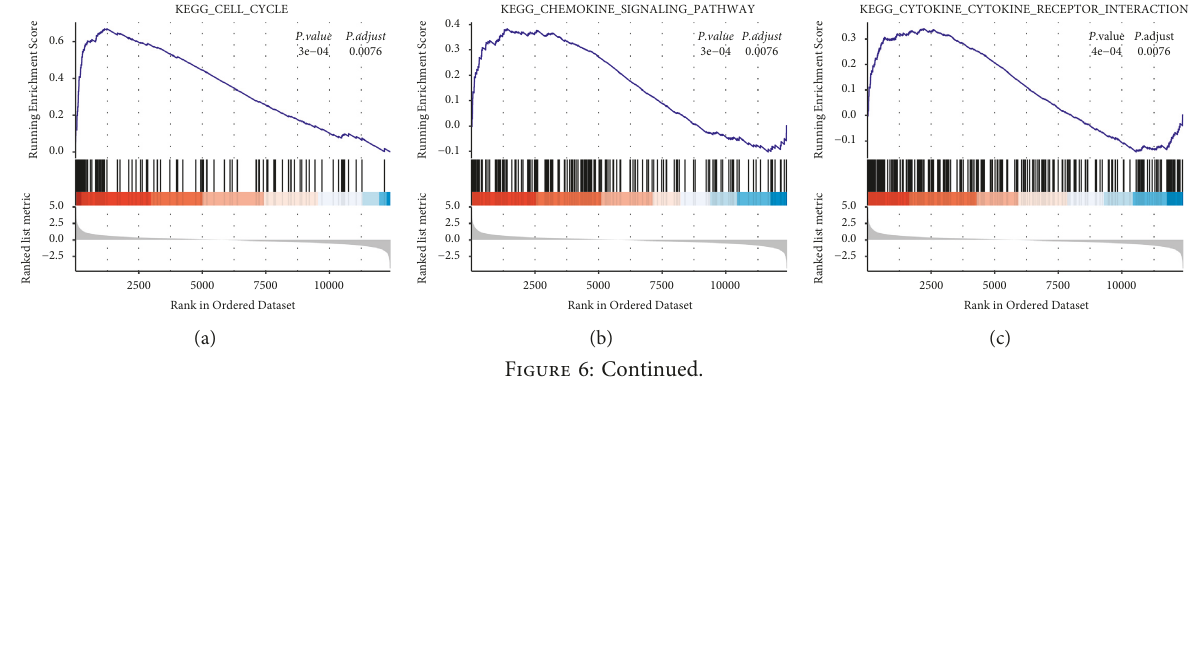
P.value P.adjust